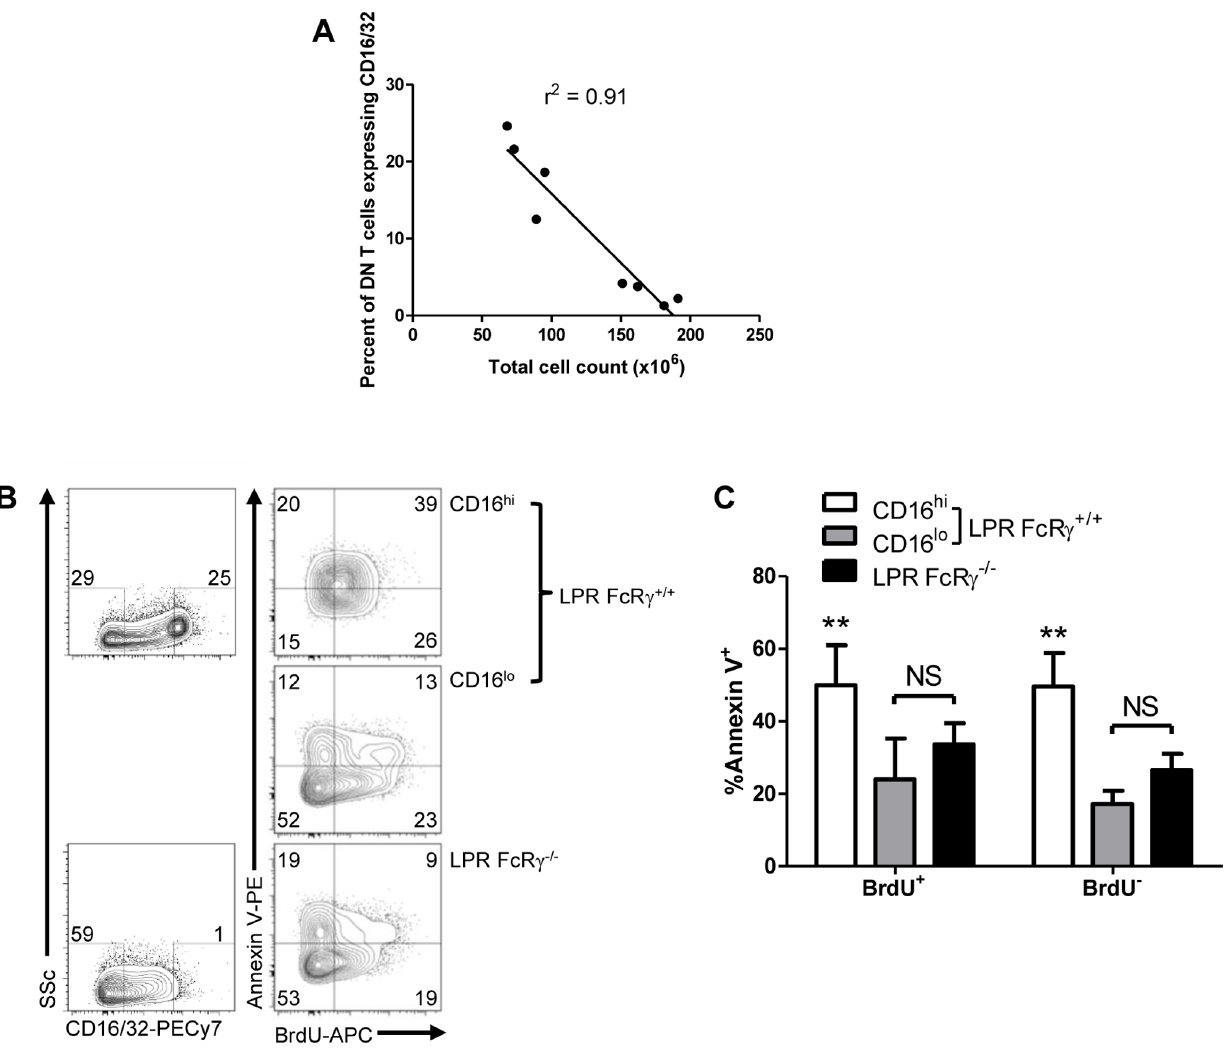
Figure 3. Fc receptor c -expressing DN T cells are lost with disease progression in LPR mice and have an increased rate of apoptosis exvivo . A. Splenocytes of young ( # 12 weeks, n=4) and older ( $ 16 weeks, n=4) female LPR mice were counted and stained for expression of CD4, CD8, NK1.1, TCR b , and CD16 and then examined by flow cytometry. The percentage of DN T cells expressing CD16 was examined as a function of total spleen cell count; linear regression r 2 =0.91, p=0.0002. B. LPR FcR c + / + (n=5) and LPR FcR c 2 / 2 mice (n=5) aged 8 weeks were fed BrdU for 6 days. Their splenocytes were then stained for expression of CD4, CD8, NK1.1, TCR b , annexin V and CD16, fixed and stained for BrdU incorporation. They were then examined by flow cytometry. Left panels show expression of CD16 versus side light scatter in LPR FcR c + / + (top) and LPR FcR c 2 / 2 DN T cells (bottom); CD16 hi and CD16 lo gates are indicated, and the numbers above each gate indicate the percentage of DN T cells falling into the indicated gates. Right panels show representative BrdU and annexin V staining in LPR FcR c 2 / 2 DN T cells (bottom) and in the CD16 lo and CD16 hi subsets of LPR FcR c + / + DN T cells (middle and top panels, respectively). Numbers inside contour plots reflect the percentage of gated cells falling into each quadrant. C. The percentages of DN T cells staining with annexin V in LPR FcR c 2 / 2 mice and in the CD16 hi and CD16 lo subsets of LPR FcR c + / + mice are presented with respect to BrdU incorporation. Two-way ANOVA p , 0.0001; **Bonferroni post tests p , 0.01 compared with either CD16 lo or LPR FcR c 2 / 2 DN T cells amongst both BrdU + and BrdU 2 DN T